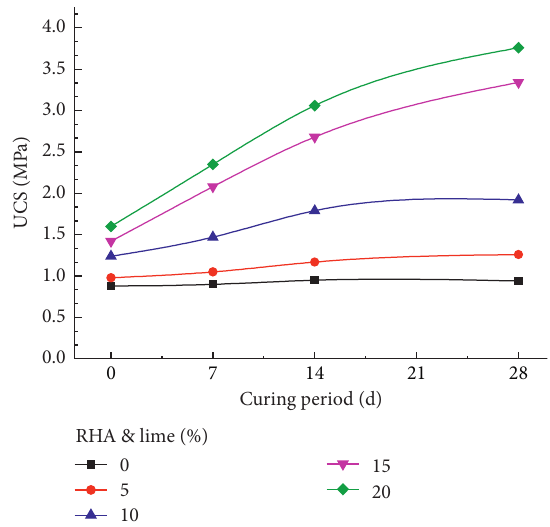
Figure 5: The UCS of soil with 34% water content.